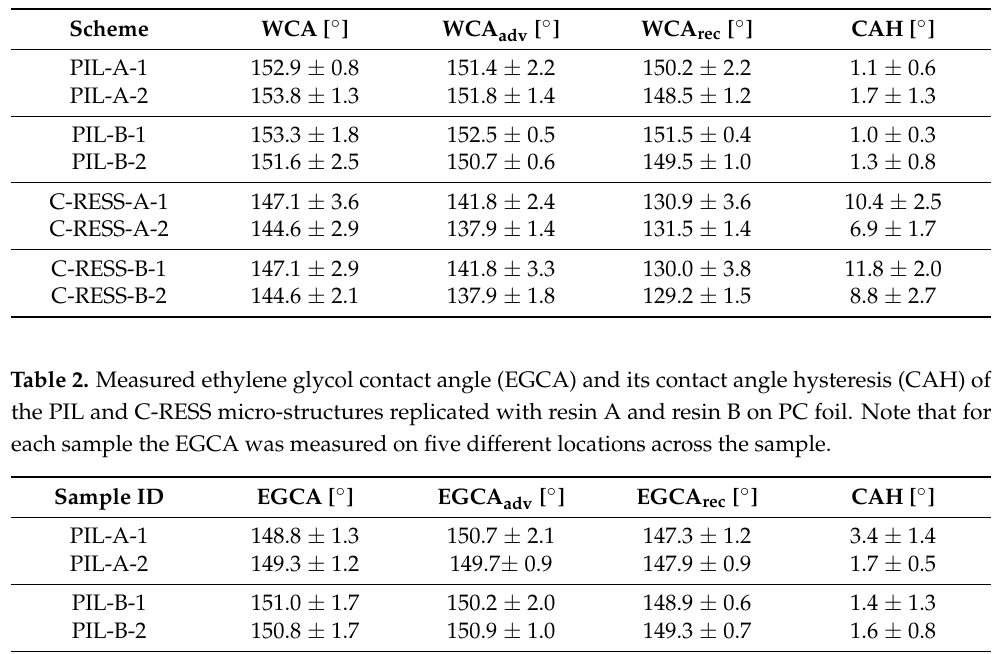
Table 1. Measured water contact angle (WCA) and its contact angle hysteresis (CAH) of the PIL and C-RESS micro-structures replicated with resin A and resin B on PC foil. Note that for each sample the WCA was measured on five different locations across the sample.